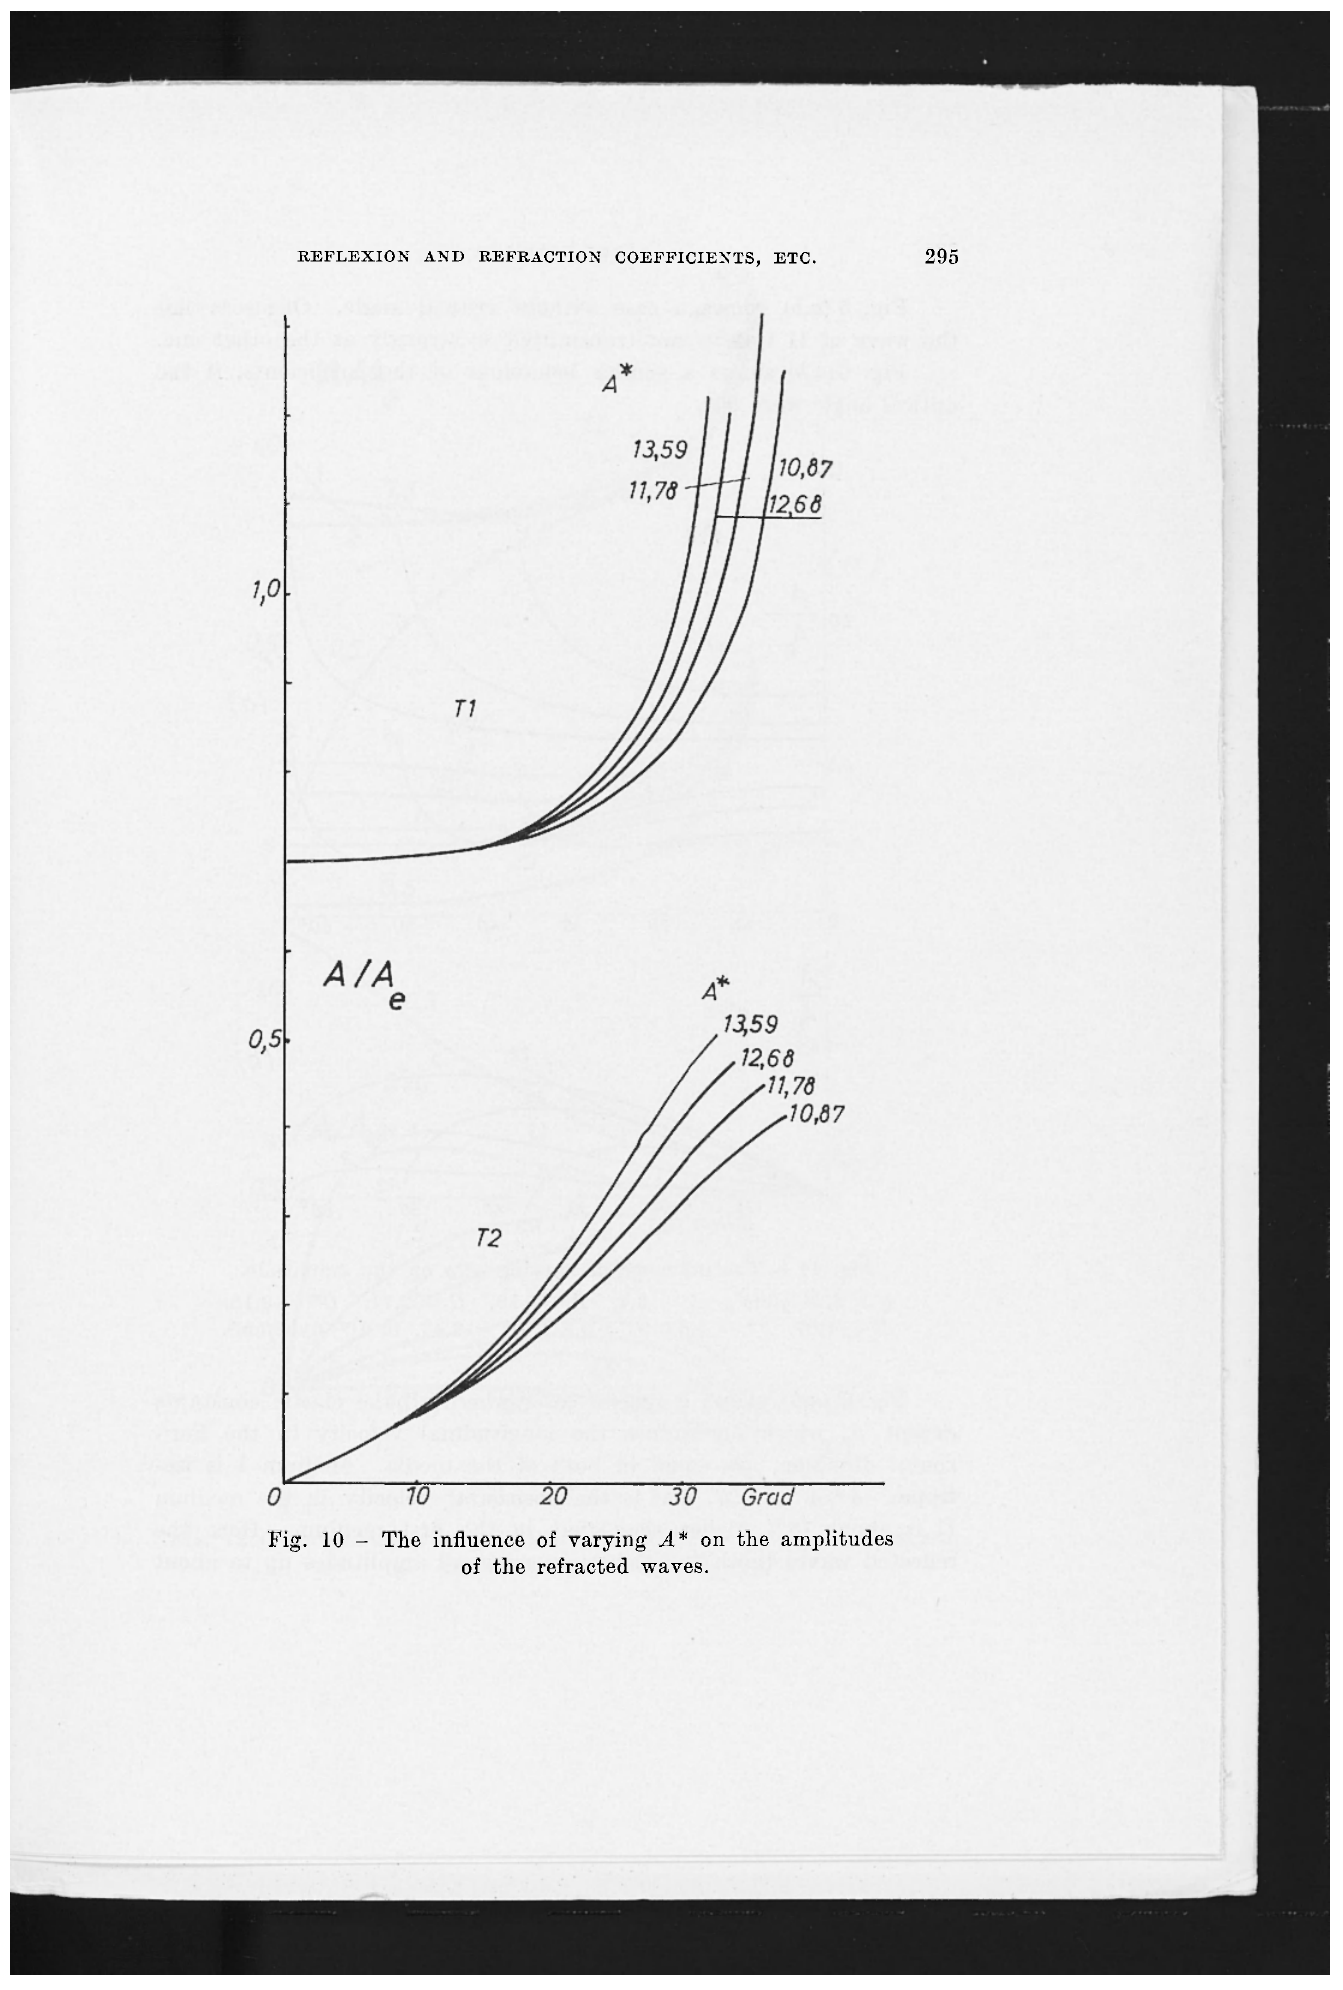
Fig. 10 - The influence of varying A* on tlie amplitudes of the refracted